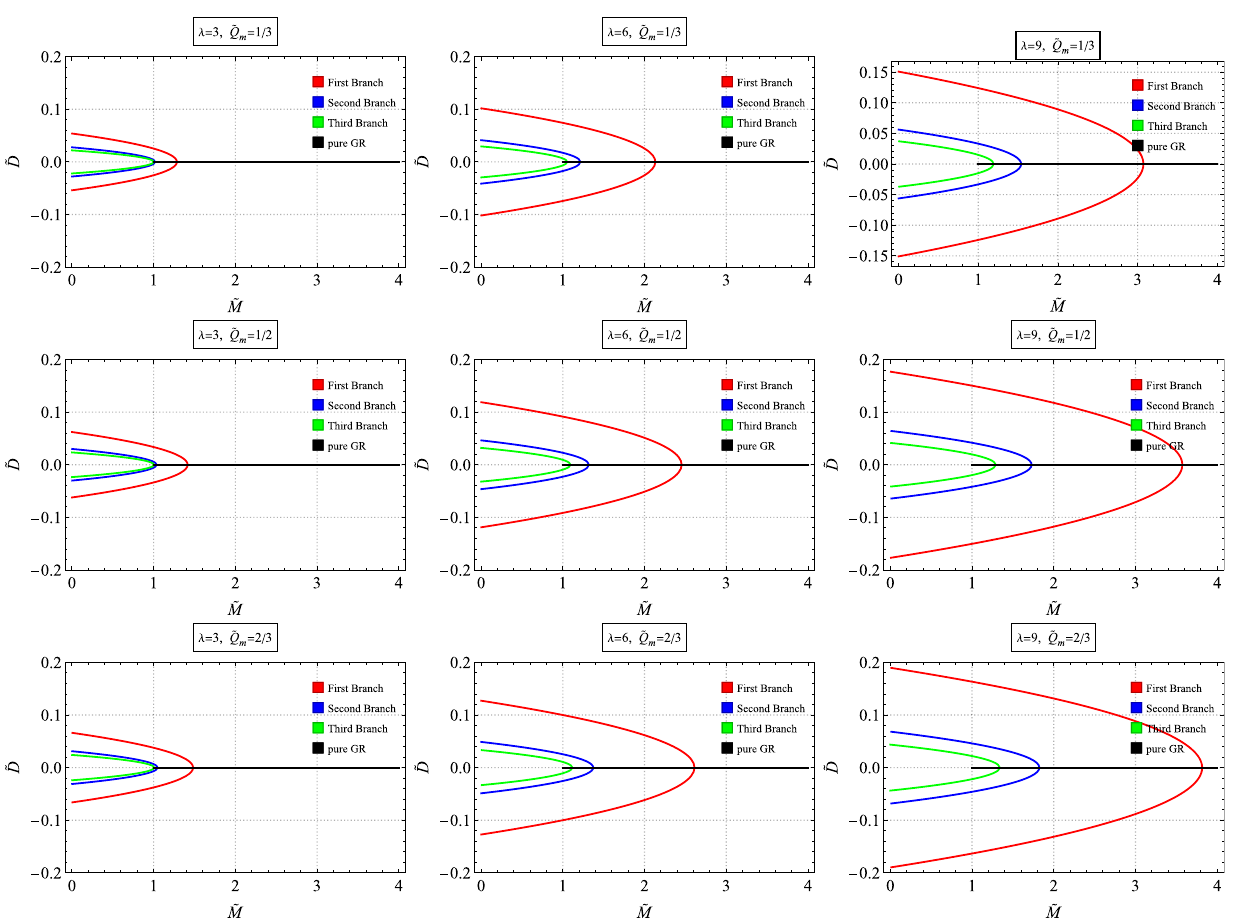
Fig. 6 Plots show the reduced scalar charge ˜ D of black holes as a function of its reduced mass ˜ M with different values of the coupling constant λ and reduced magnetic charge ˜ Q m for the first three branches of scalarized dyonic RN black